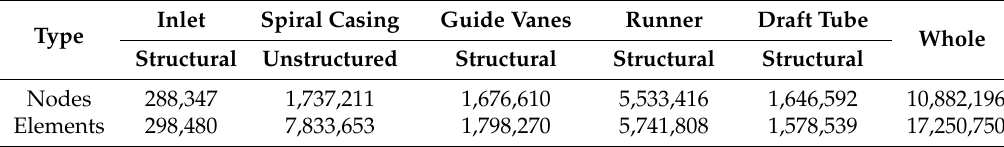
Figure 2. Mesh independence test regarding hydraulic efficiency. Table 3. Mesh of different hydraulic parts.